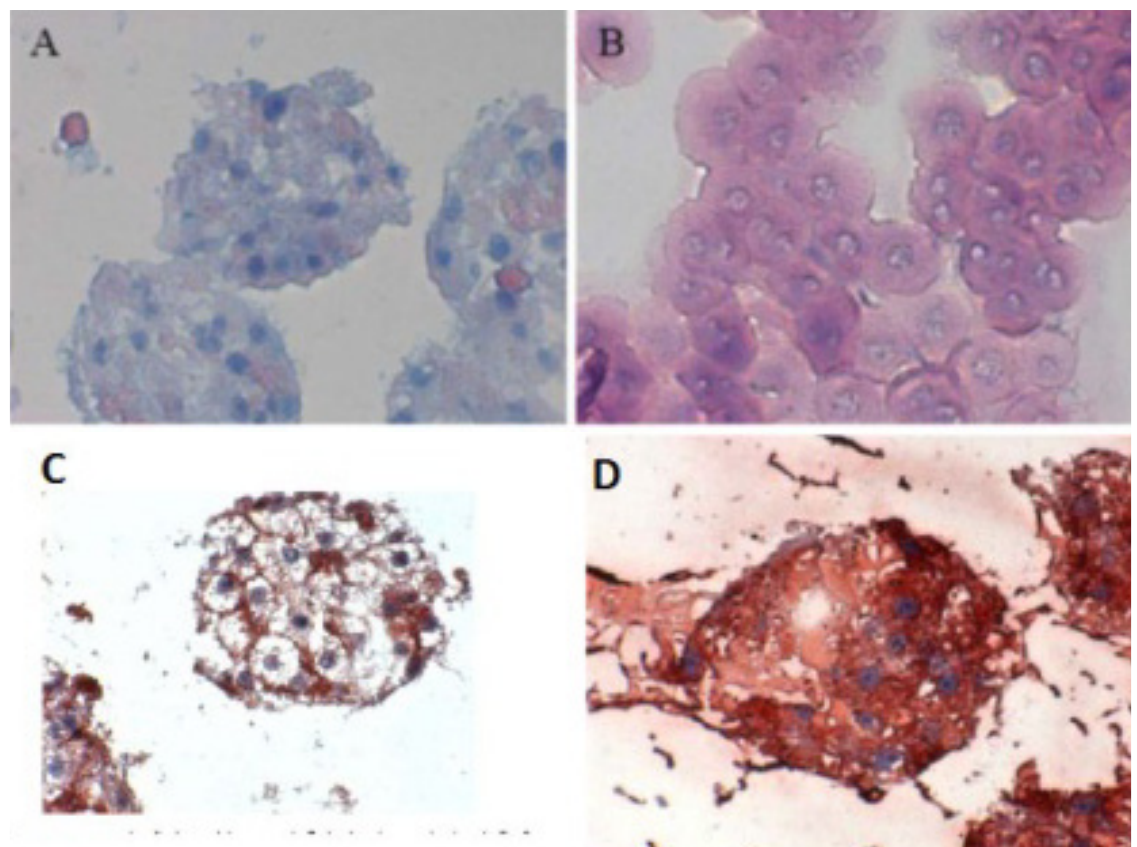
Figure 3. Immunological detection of hepatospecific marker in spheroid culture model (A and B) Extracellular matrix in the spheroid (Magnification 400×), (B) individual cells (magnification 400×). (C) Localization of the gap junctions in Spheroid after incubation with anti-Cx32; (Magnification 400×). (D) Distribution of hepatocytes in the Spheroid (magnification 400×). Scale bar is 100 μ